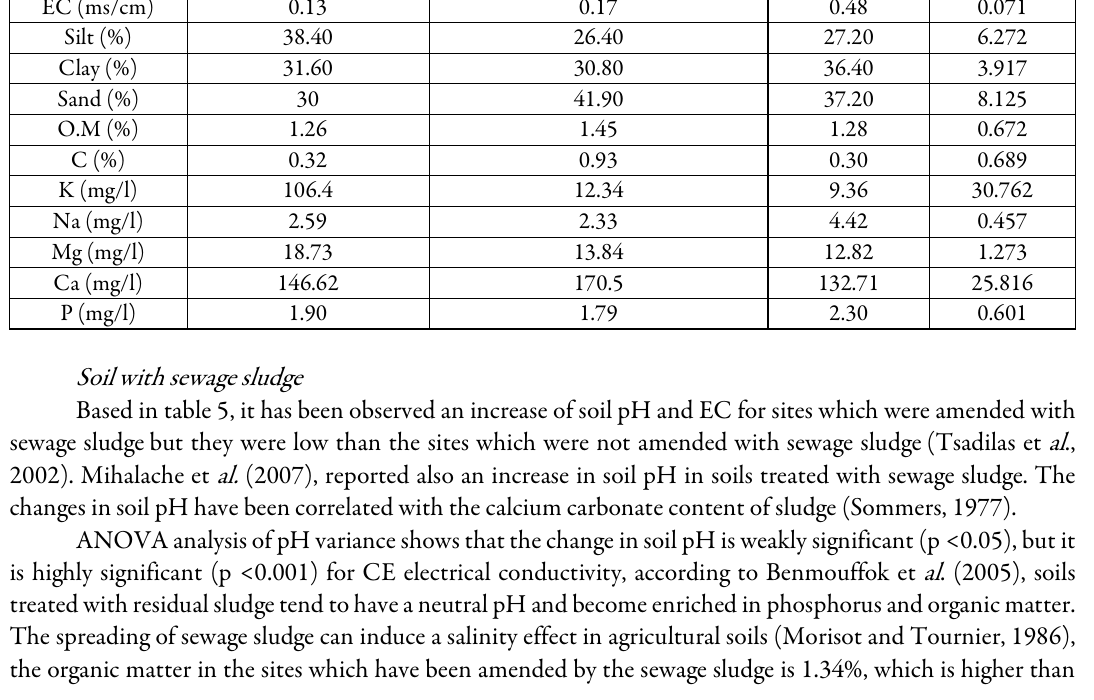
Table 4. Mean values of physicochemical parameters of soil control before and after harvesting Before application of Treatment T sewage